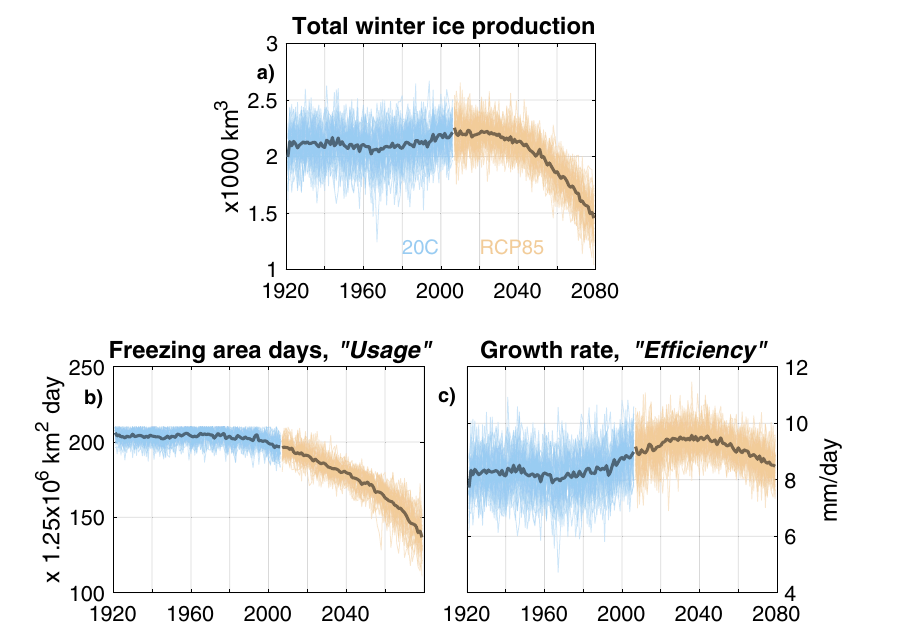
Fig. 4 | Decomposing winter ice production. Winter ice production ( a ) and decomposition into freezing area days ( b ) and growth rate ( c ). All 40 ensemble membersshowninlightblue(20C)andorange(RCP8.5).Ensemble-meanindicated